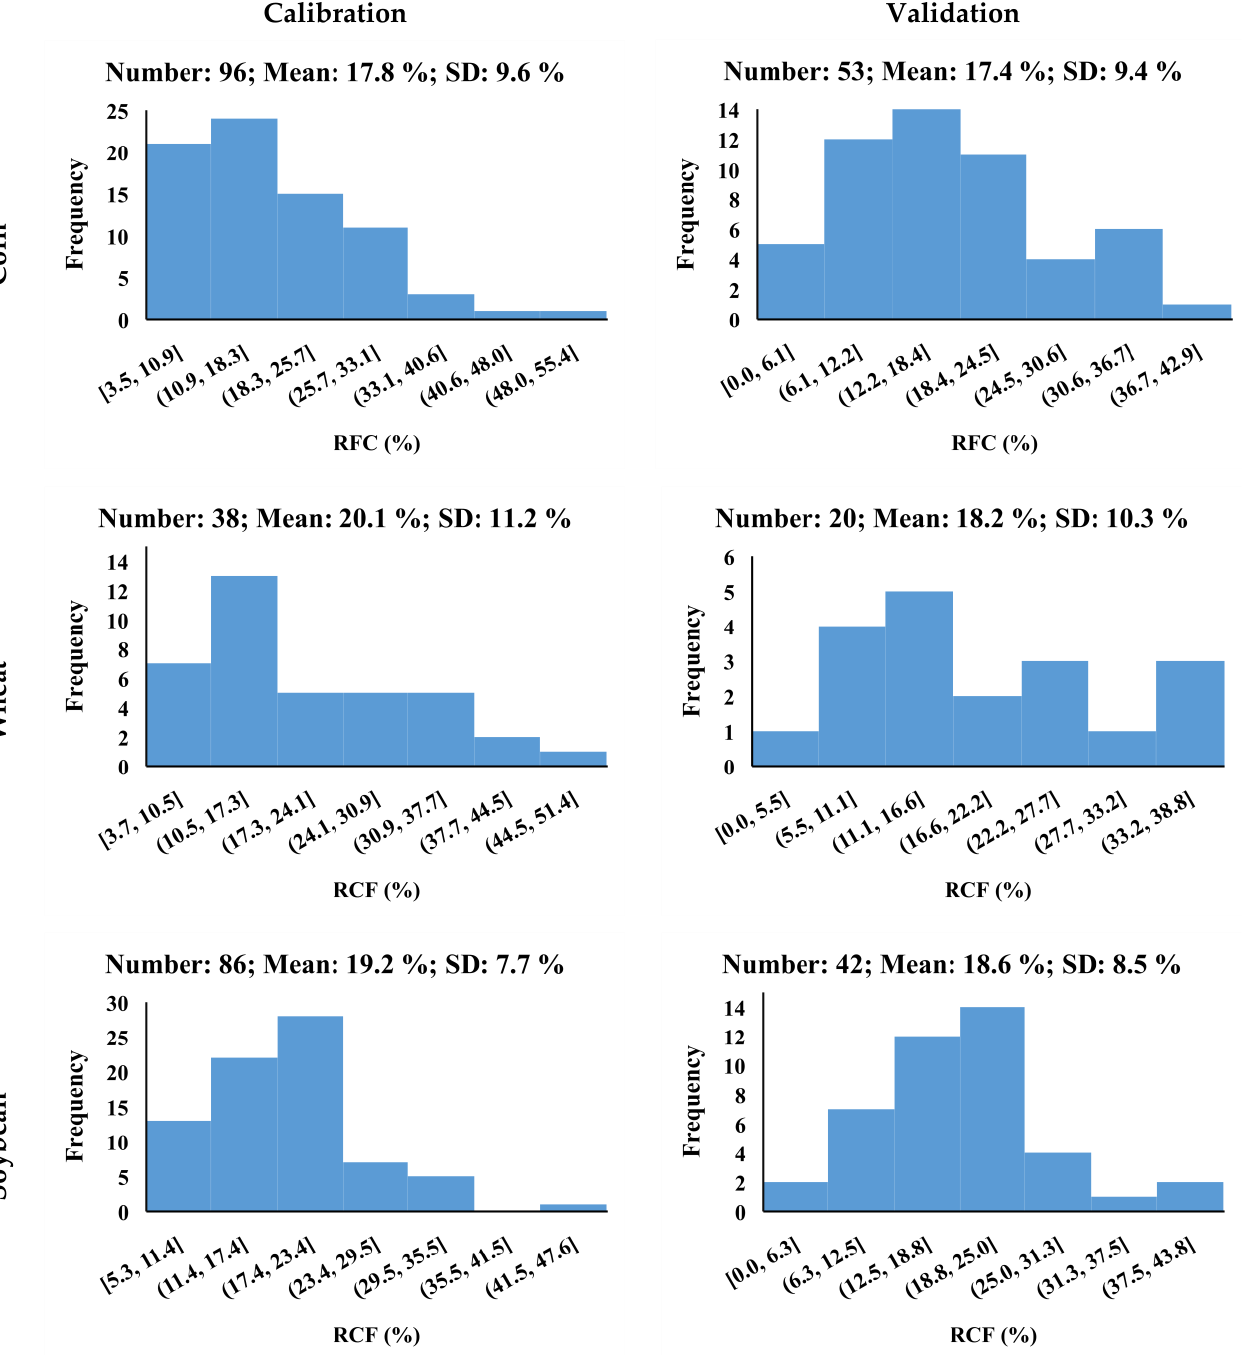
Figure 2. Frequency distribution of RCF values of corn, wheat and soybean crops for calibration and validation data in different classes .